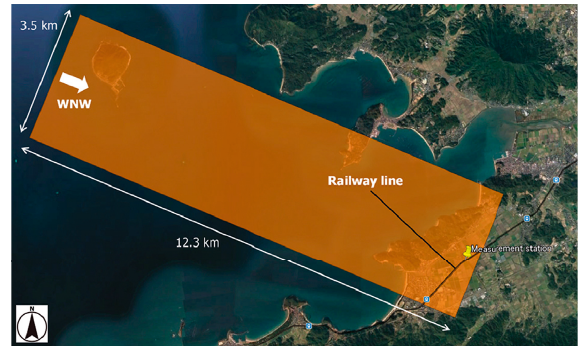
Figure 12: Calculation area and